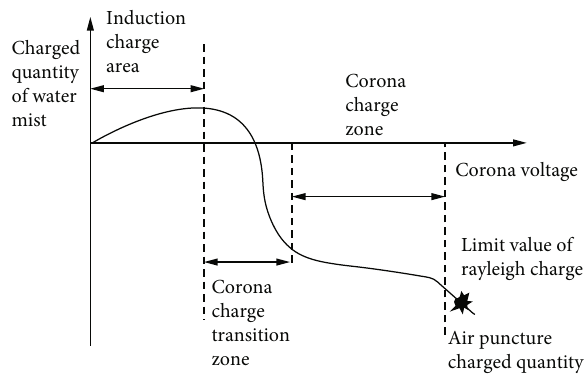
Figure 6: Schematic diagram of droplet